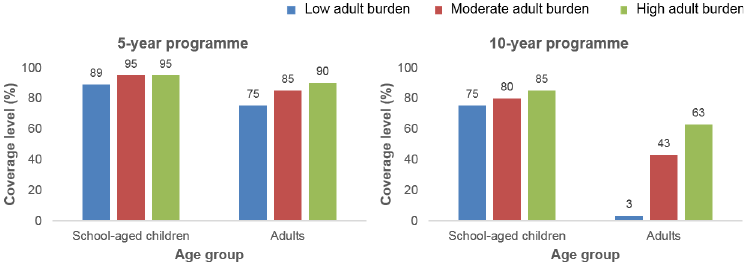
Fig 5. Coverage levels required to reach the World Health Organization (WHO) goal of morbidity control. High prevalence settings ( (cid:21) 50% SAC baseline prevalence) showing coverage levels of school-aged children (SAC; 5–14 years of age) and adults required to reach the WHO goal of morbidity control within 5- and 10-year treatment programmes (see S1A Fig for 15-year treatment